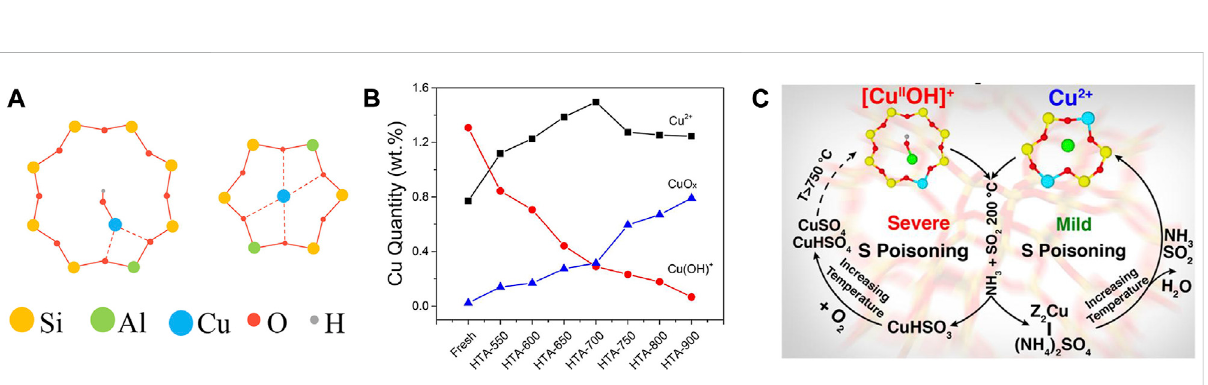
FIGURE 2 (A) The schematic representation of (Left) the 8 MR with a single Al atom and a Cu(OH) + complex in CHA cage and (Right) the 6 MR with two Al atoms located diagonally and a Cu 2+ cation in the center. (B) Estimation of Cu 2+ , Cu(OH) + , and CuO x in fresh and hydrothermally aged